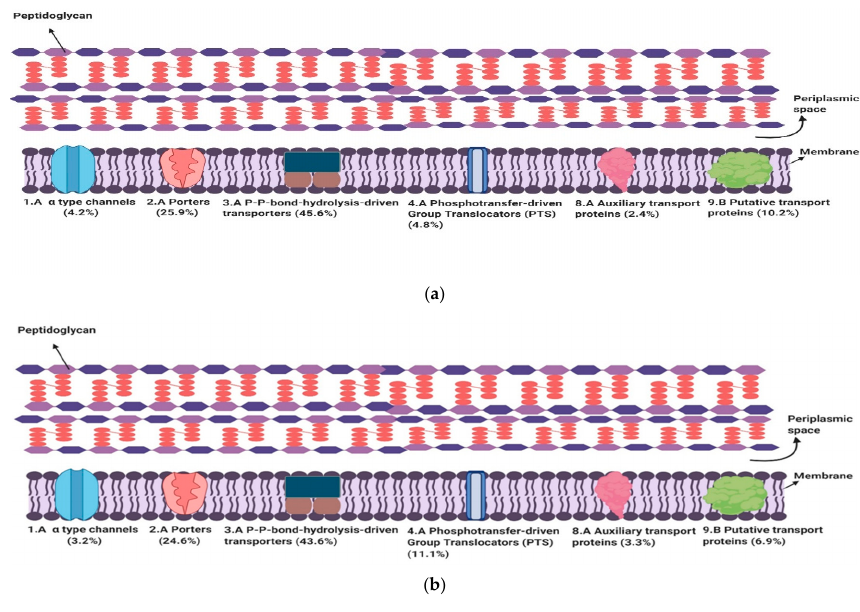
Figure 1. The average percentages of major classes in the six only probiotic strains ( a ) and the four pathogenic and probiotic strains ( b ). ( a ) The best represented TC subclasses for transport proteins